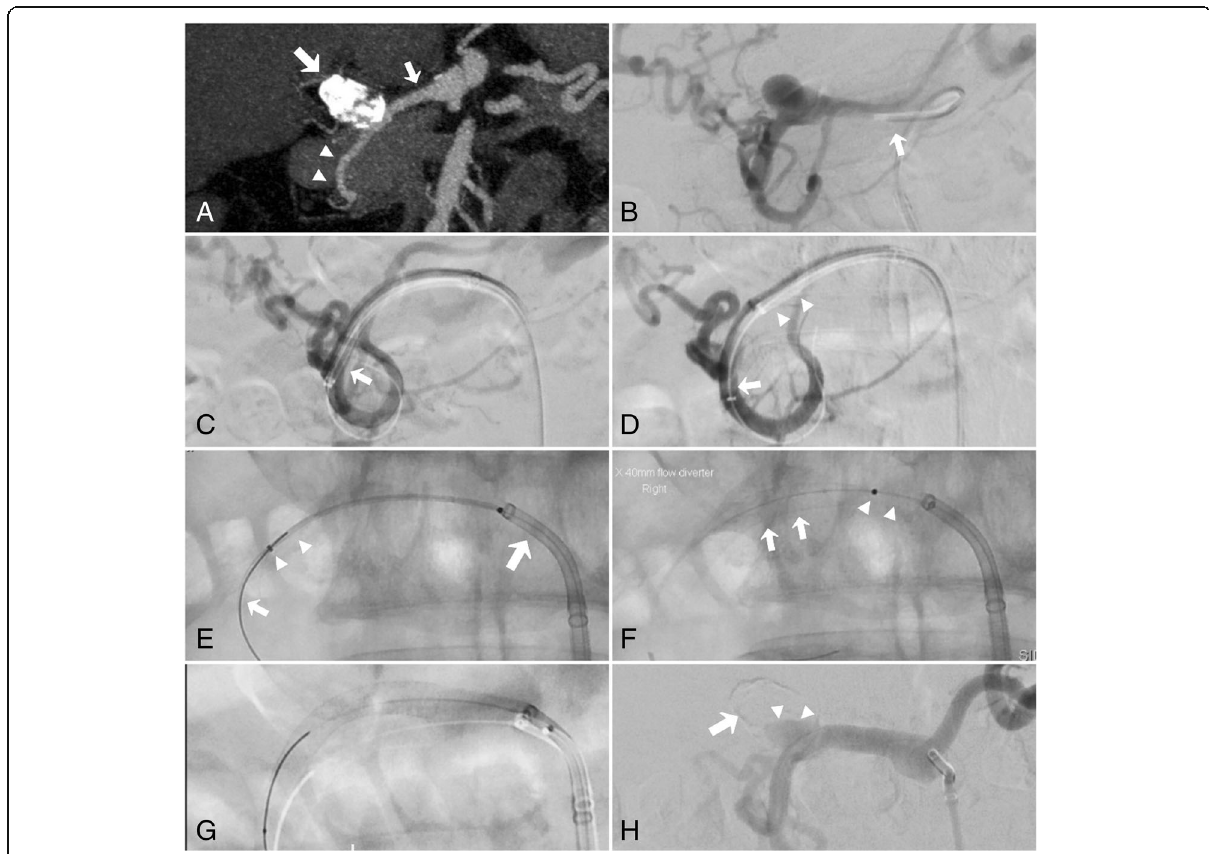
Stasis Phase 1: no stasis (arterial phase clearance prior to capillary phase)